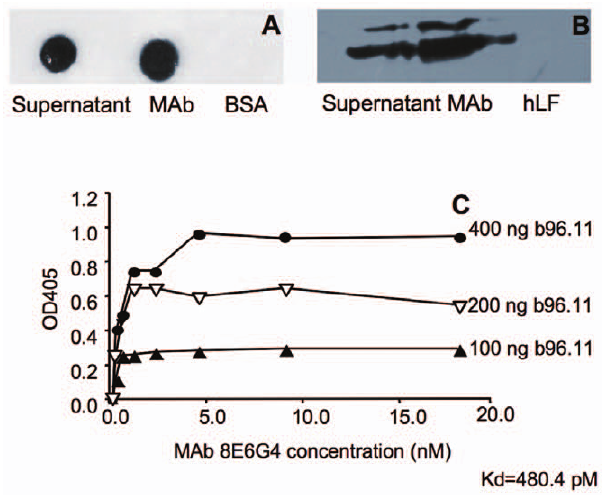
Figure 1. MAb 8E6G4 binds specifically to b96.11. A: Purified MAb 8E6G4, supernatant of hybridoma 8E6G4, or BSA were analyzed for binding by b96.11 by Dot blot. From left: supernatant of hybridoma 8E6G4, purified MAb 8E6G4, and BSA. B: Binding of MAb 8E6G4 and supernatant of hybridoma 8E6G4 to b96.11 was analyzed by immunoprecipitation followed by Western blot analysis. Binding of MAb 8E6G4 to control antibody hLF served as negative control. From left: supernatant of hybridoma 8E6G4 with b96.11, MAb 8E6G4 with b96.11, and MAb 8E6G4 with hLF. C: MAb 8E6G4 binds to b96.11 with high affinity. Dissociation constant was calculated by non-competing ELISA. Different concentrations of b96.11 were tested for binding by MAb 8E6G4. Kd of each concentration was calculated. The Kd